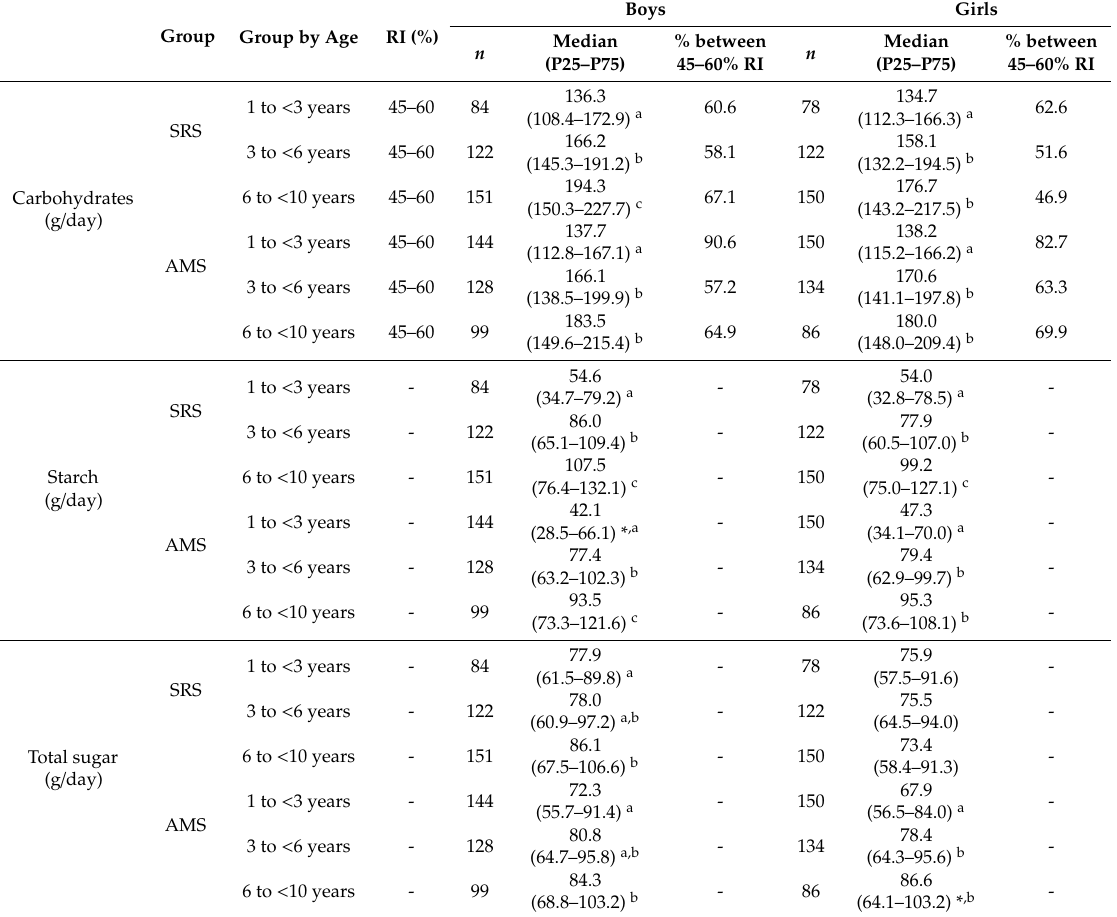
Table 2. Total carbohydrates, starch and total sugar usual intakes and prevalence of adequacy for carbohydrate intake (percentage of population between 45–60% RI) by gender and age group in the Spanish Pediatric Population (EsNuPI)